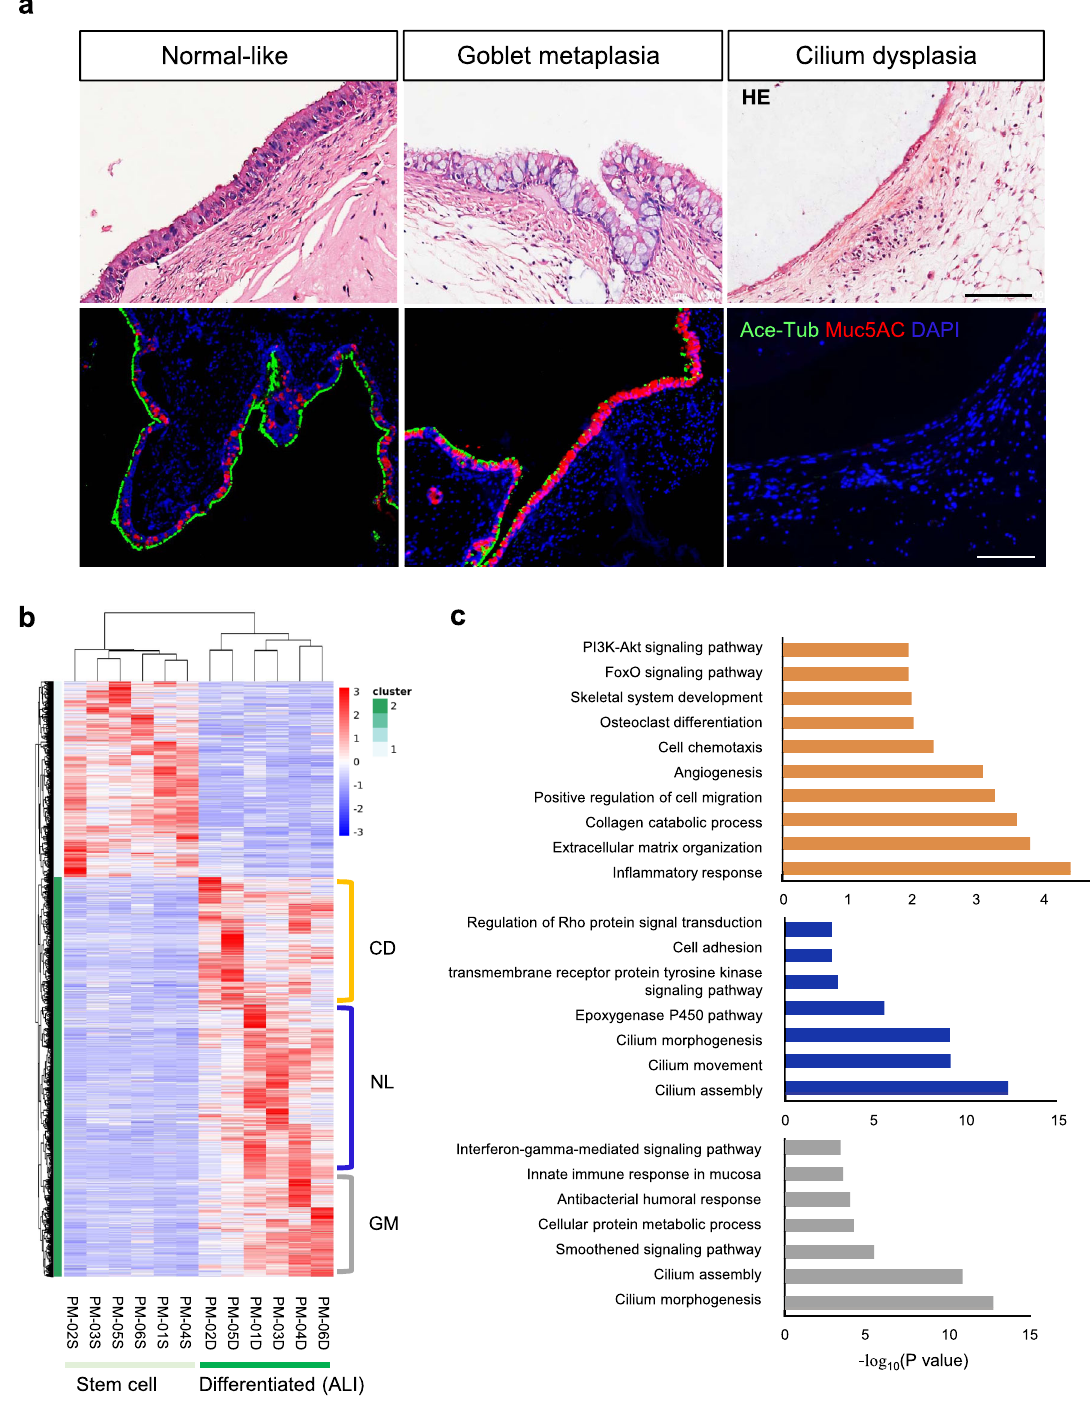
Fig. 6 Characterization of basal cells derived from normal-looking regions of TO patients. a HE staining showing distinct cell commitments of patient- matched (PM) normal-looking region-derived TBBCs (PM n = 6 independent biological samples). Differentiation ef fi ciency was assessed by IF staining on xenograft sections with Ace-Tub (ciliated) and Muc5AC (goblet) cell-type-speci fi c markers. Scale bar, 100 μ m. b PM-TBBCs prior to and post 20-day ALI differentiation were subjected to RNA-Seq. Differential gene expression pro fi les were visualized by heatmap with hierarchical clustering. c GO and KEGG enrichment analyses were performed to reveal molecular characteristics of three sub-groups, corresponding to normal-like (NL), goblet-metaplasia (GM), and cilium dysplasia (CD)